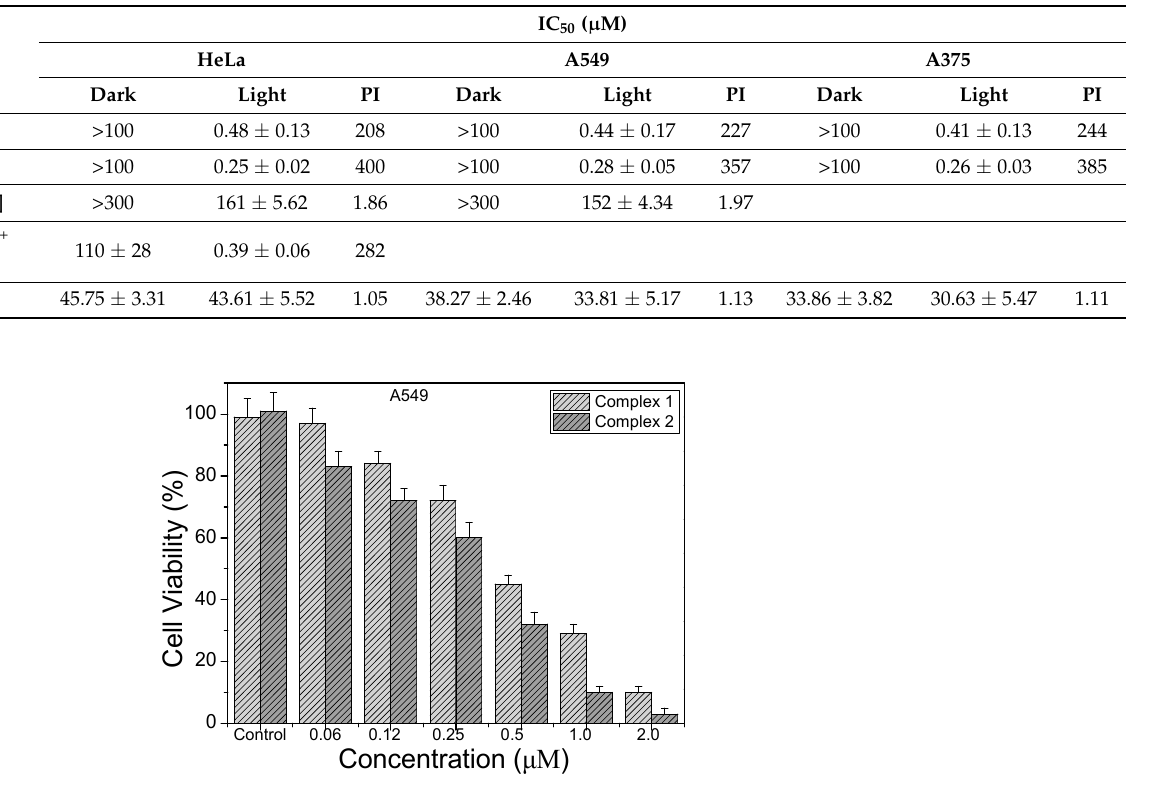
Table 1. (Photo)cytotoxicity against selected cell lines.